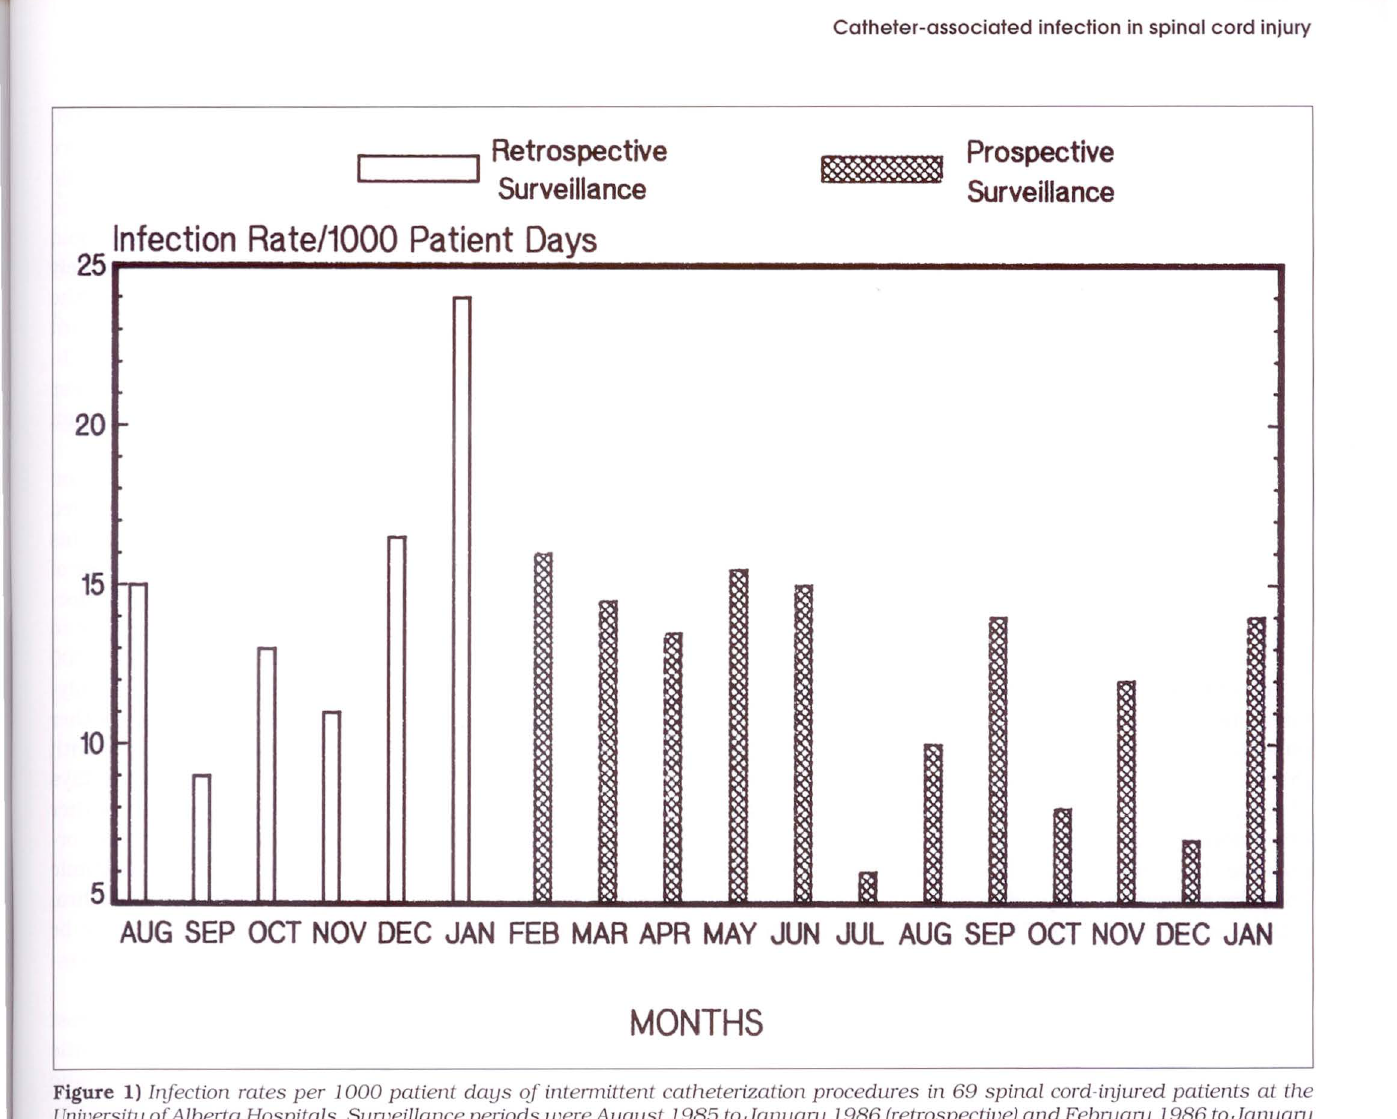
Infection rate by site and complete ness of cord lesion